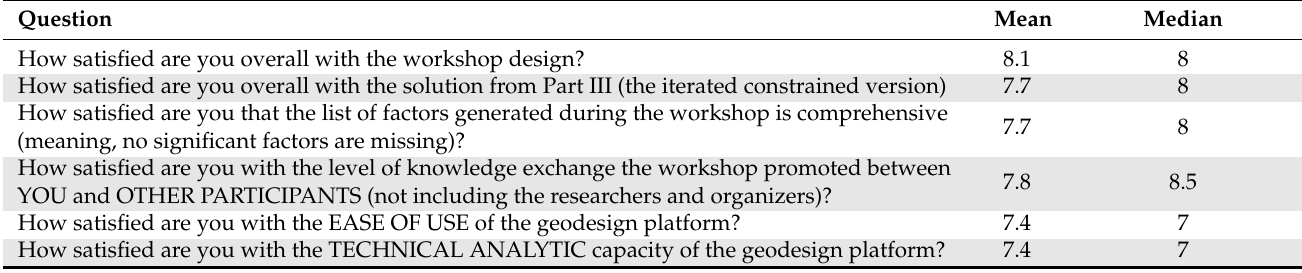
Table 7. Survey results demonstrating participant satisfaction with various facets of the workshop process (0 = dissatisfied, 9 = satisfied; n = 12).